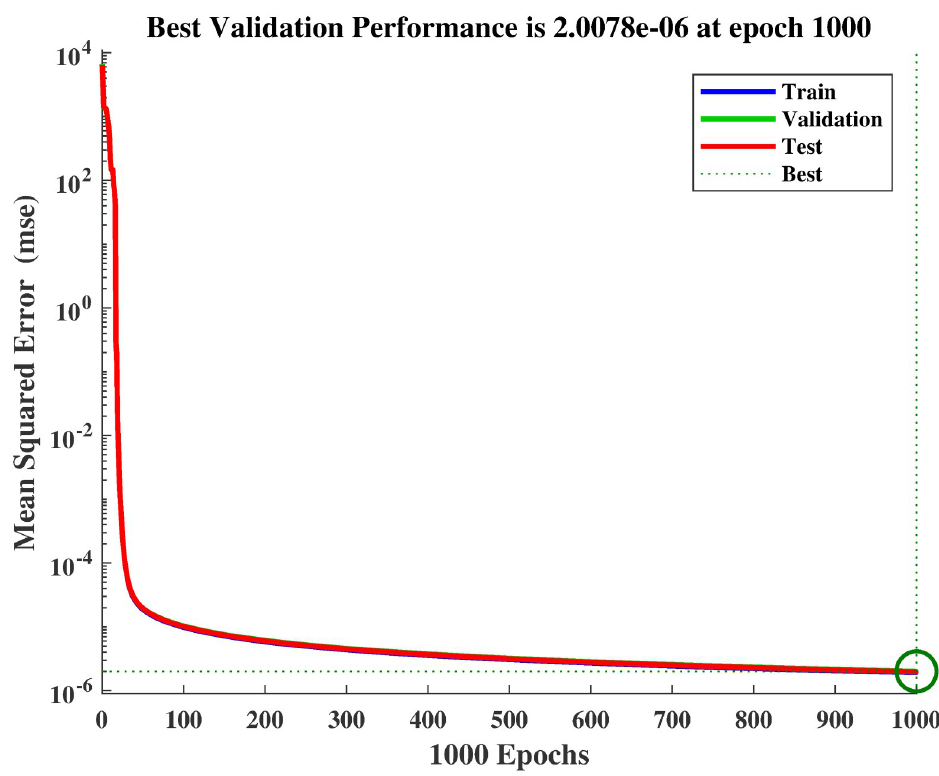
Fig 9. Mean square error convergence during the NN